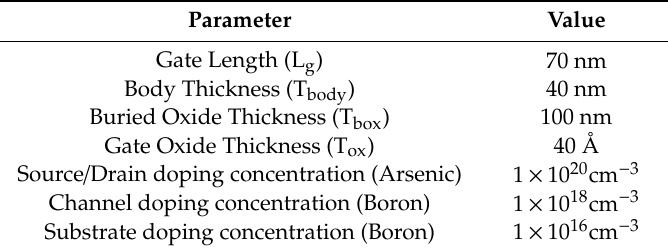
Table 1. Device parameters for poly-Si 1T DRAM simulation.